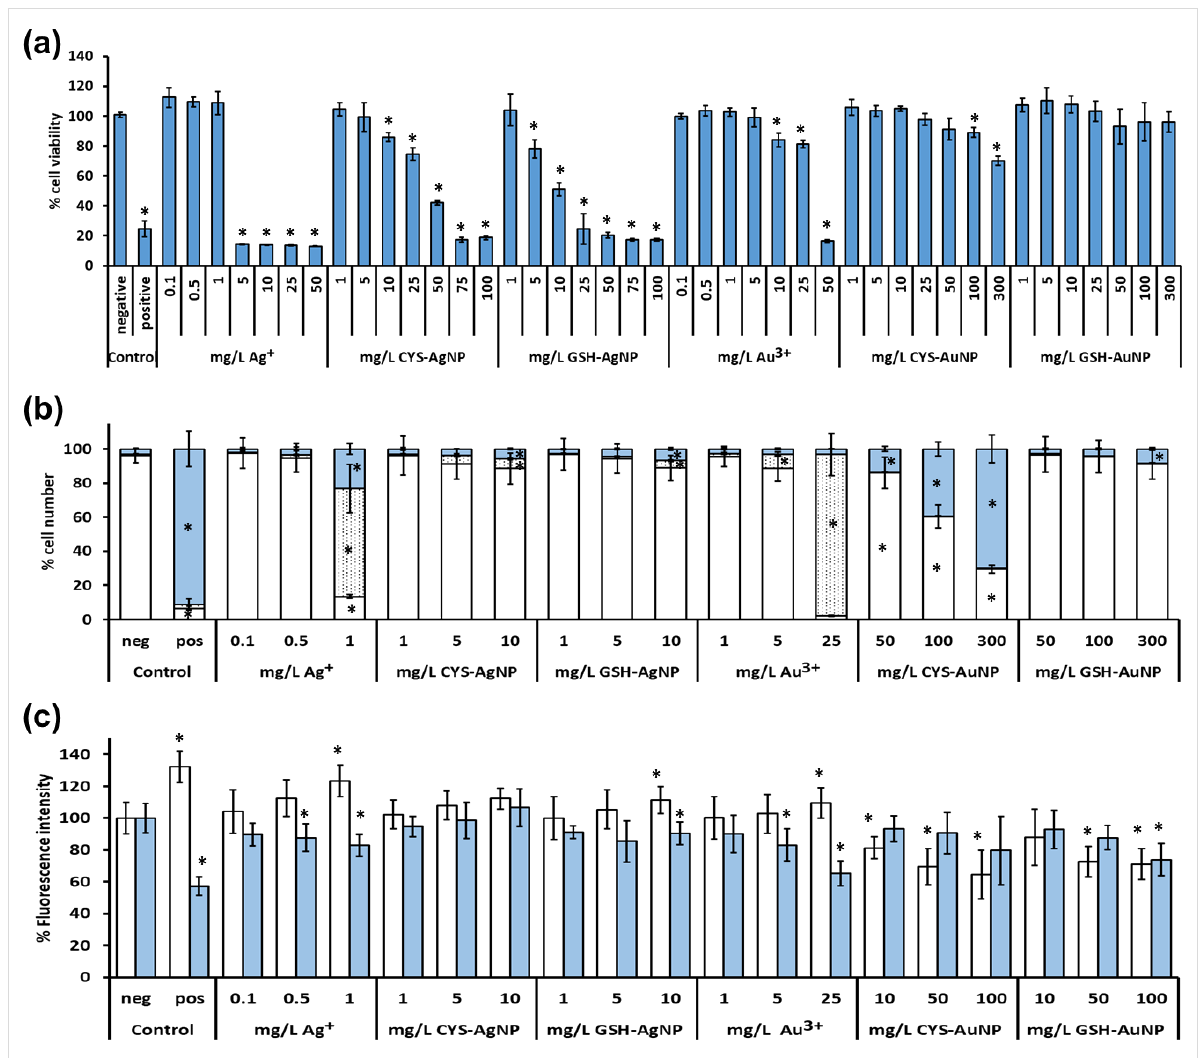
Figure 4: (a) Viability of L929 cells exposed to silver (AgNPs) and gold nanoparticles (AuNPs) stabilized with cysteine (CYS) or glutathione (GSH), Ag + and Au 3+ ions during 24 h and determined by the MTT cytotoxicity assay. (b) The effect of AgNPs, AuNPs, Ag + , and Au 3+ on the number of live (white columns), early apoptotic (dotted columns) and late apoptotic (blue columns) L929 cells after 24 h exposure, determined by flow cytometry after Annexin V/PI staining. (c) The effect of AgNPs, AuNPs, Ag + , and Au 3+ on the level of peroxy radical (white columns, as measured by DCFH-DA assay) and total GSH (blue columns, as measured by MBCl assay) in L929 cells after 4 h of exposure. Negative controls (neg) were untreated cells. Positive controls (pos) were cells treated with DMSO for MTT and Annexin V/PI assays, or with the t -butylhydroxyde for DCFH and MBCl assays. The results are expressed as percentage of negative controls and given as mean values obtained from three independent experiments. Standard devia- tions are presented as scale bars. Values marked with asterisk (*) differ significantly from the negative control ( P <